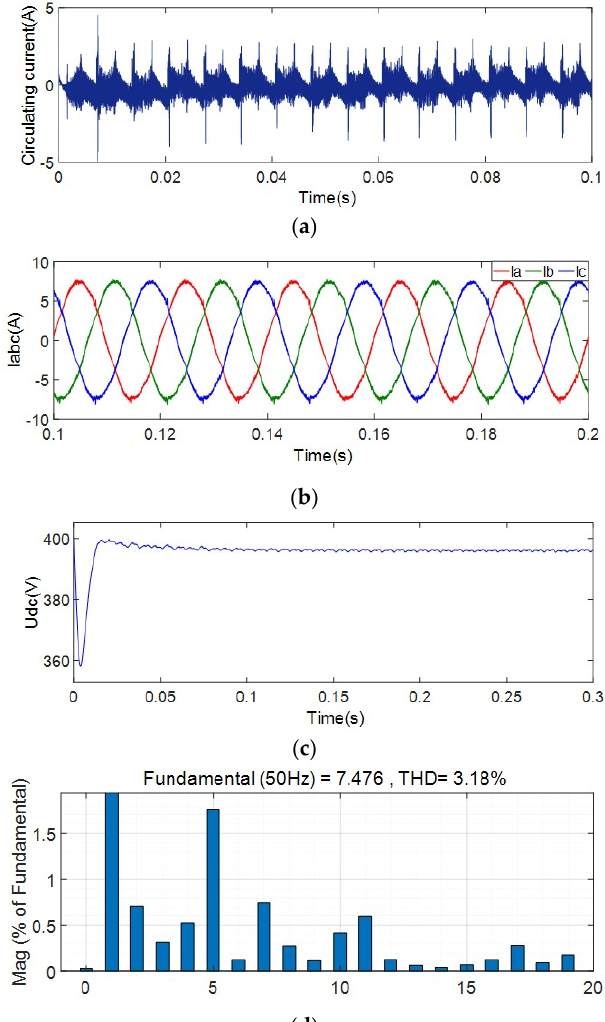
Figure 14. The control scheme of suppressing circulating current is added under different conditions of the positive and negative DC bus inductance of the parallel module ( a ) Positive DC bus circulating current. ( b ) AC side current. ( c ) DC side output voltage. ( d ) THD of AC side current.